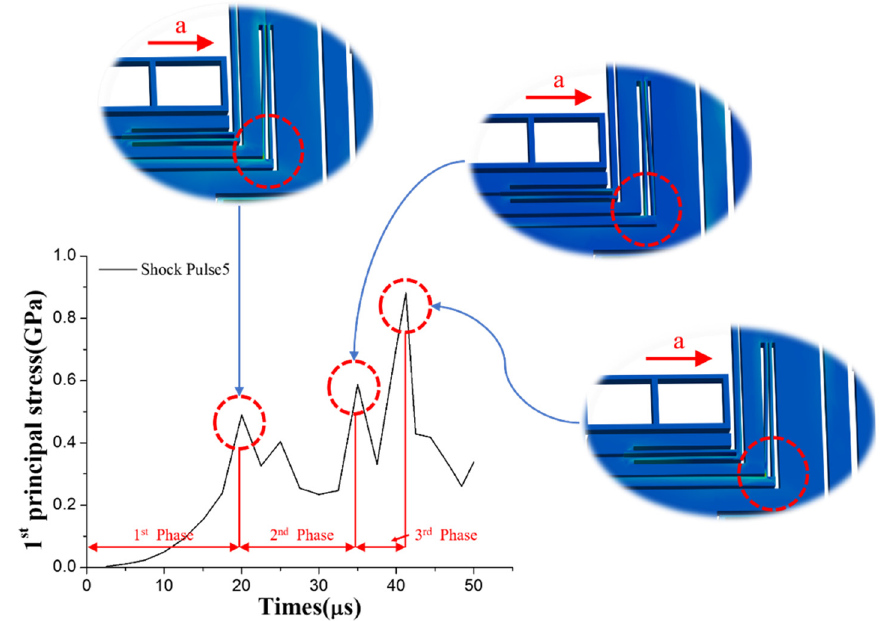
Figure 11. First principal stress of the MEMS tuning fork gyroscope and the deformation of weak position under the impact of Shock Pulse 5 (a 0 = 25,000 g, τ = 50 µs, the red arrows with ‘a’ indicate the shock direction relative to the MEMS tuning fork gyroscope).